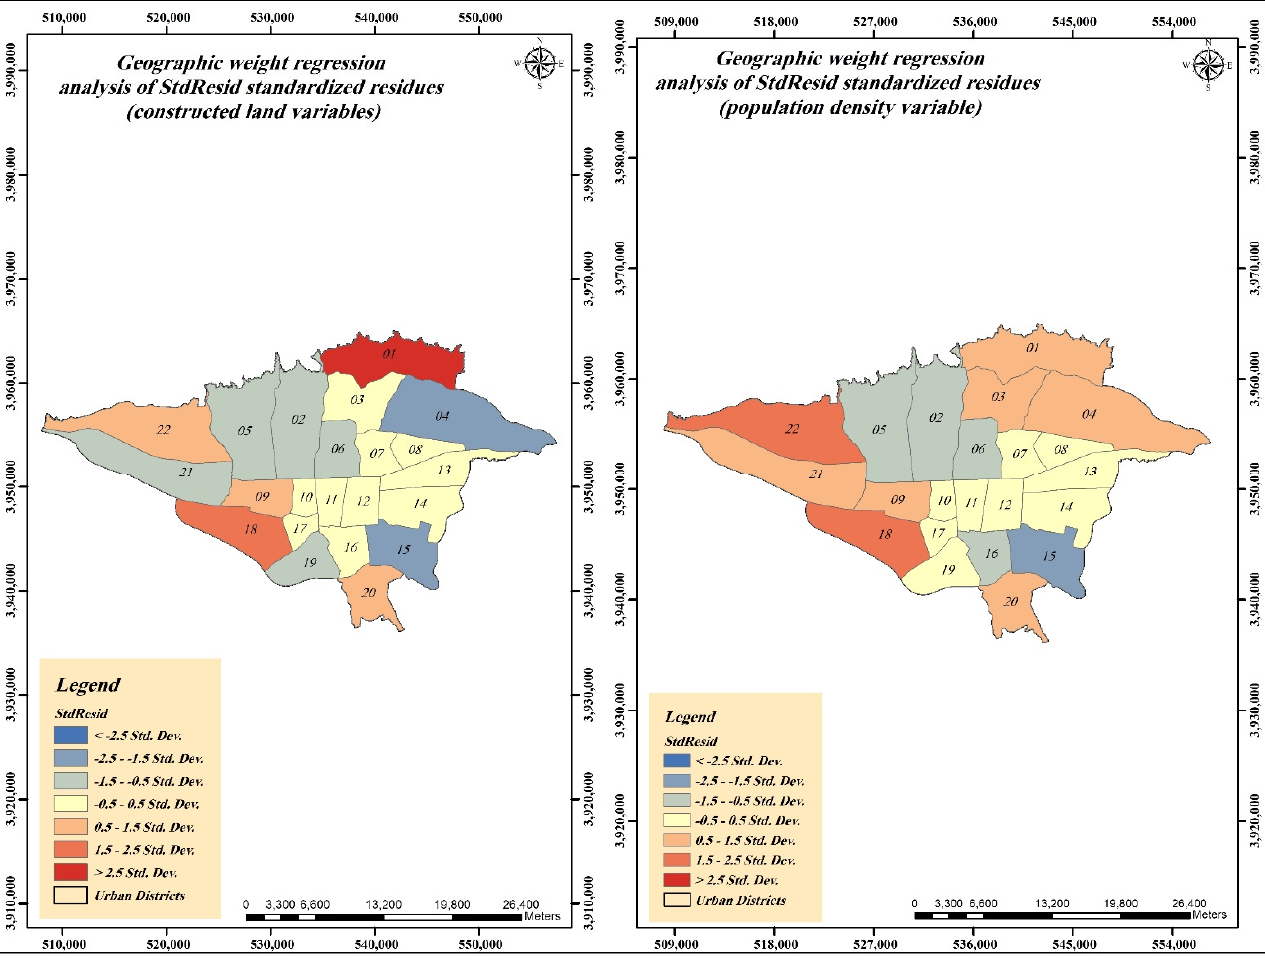
Figure 6. The output layer of GWR analysis of standardised StdResid.